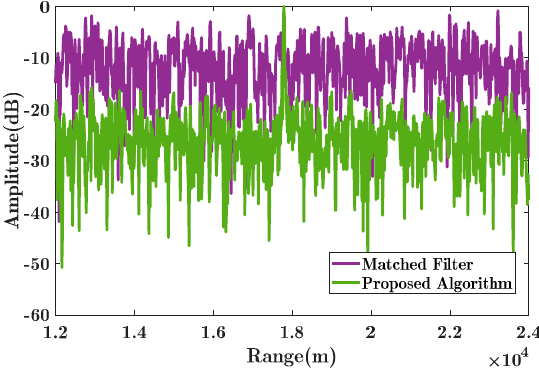
Figure 6. Result of oblique projection processing.